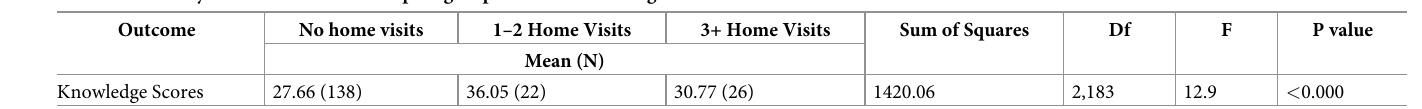
Table 3. One-way ANOVA results to compare group means of knowledge scores.